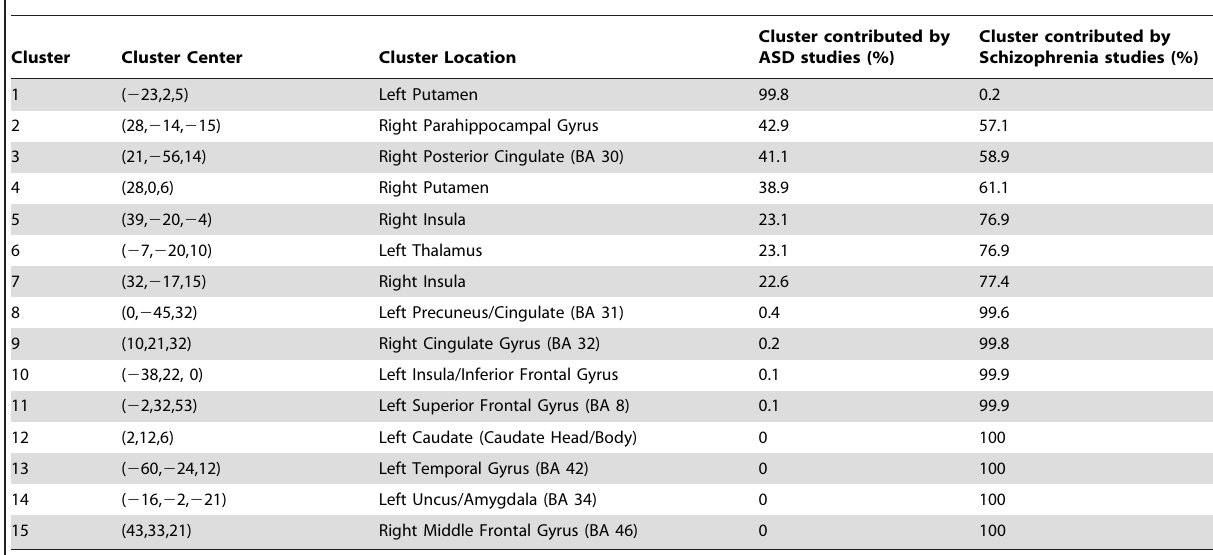
Table 2. ALE Clusters formed in less grey